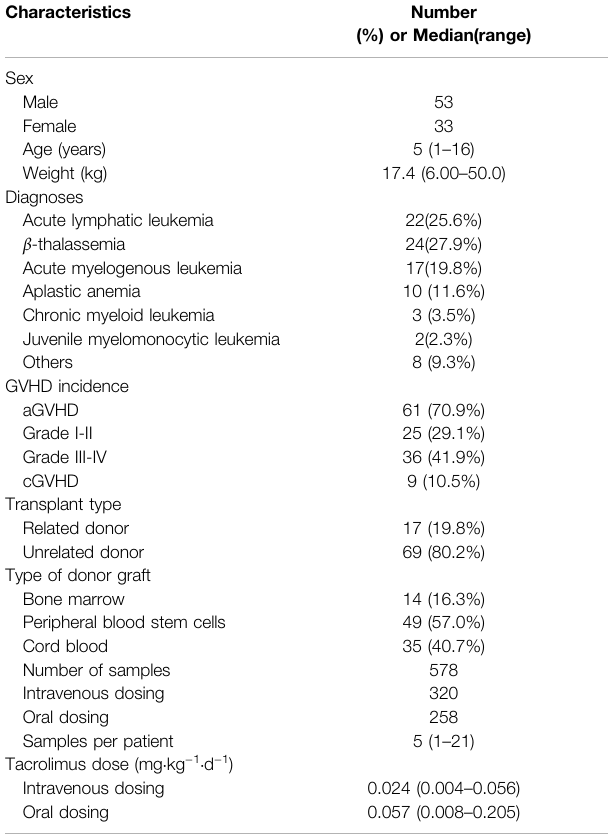
TABLE 1 | Patient characteristics in pediatric HSCT Recipients ( n = 86). Characteristics